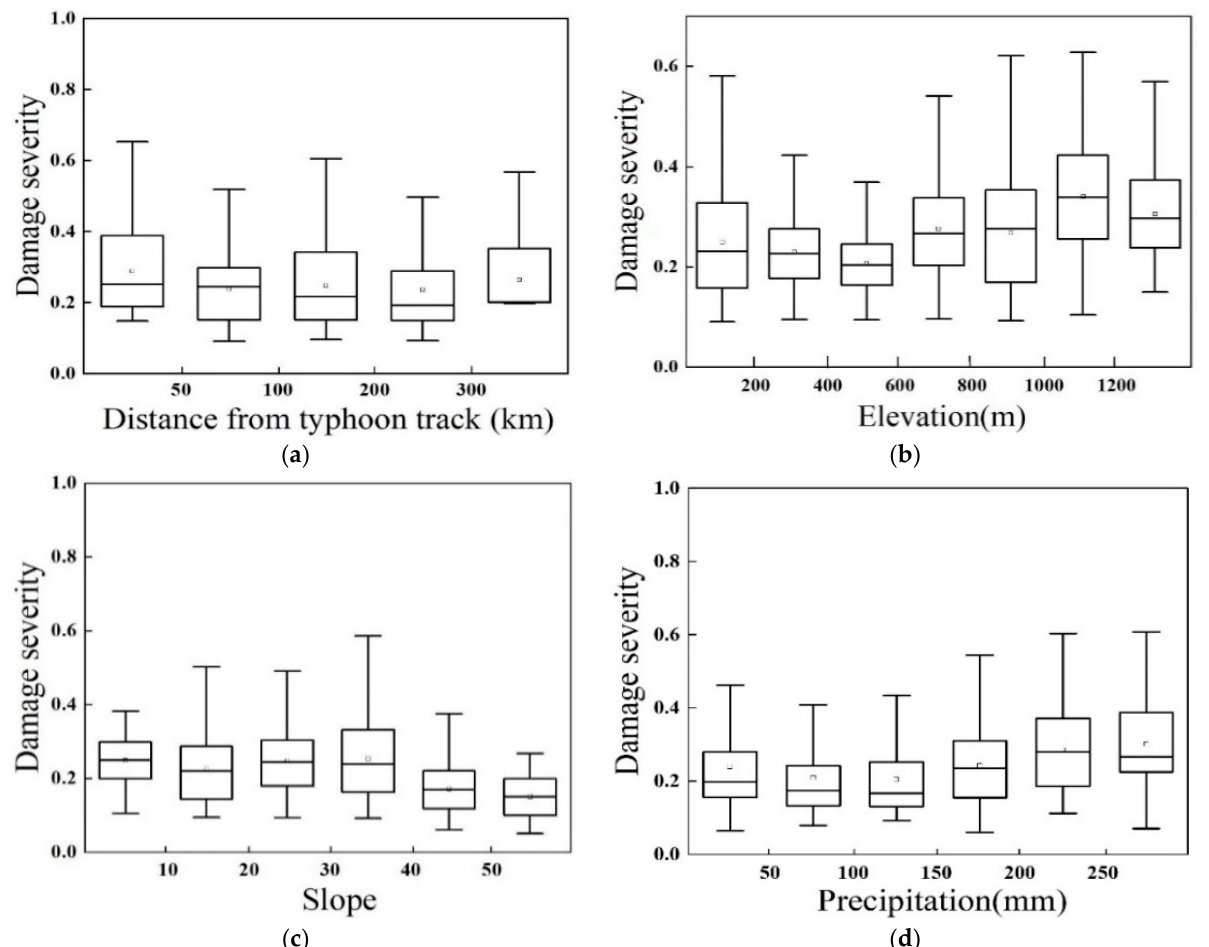
Figure 9. The relationships between forest damage severity (0 − 1) with elevation, slope, distance from typhoon track and precipitation (( a ): distance from typhoon track; ( b ): elevation; ( c ): slope; ( d ): precipitation).